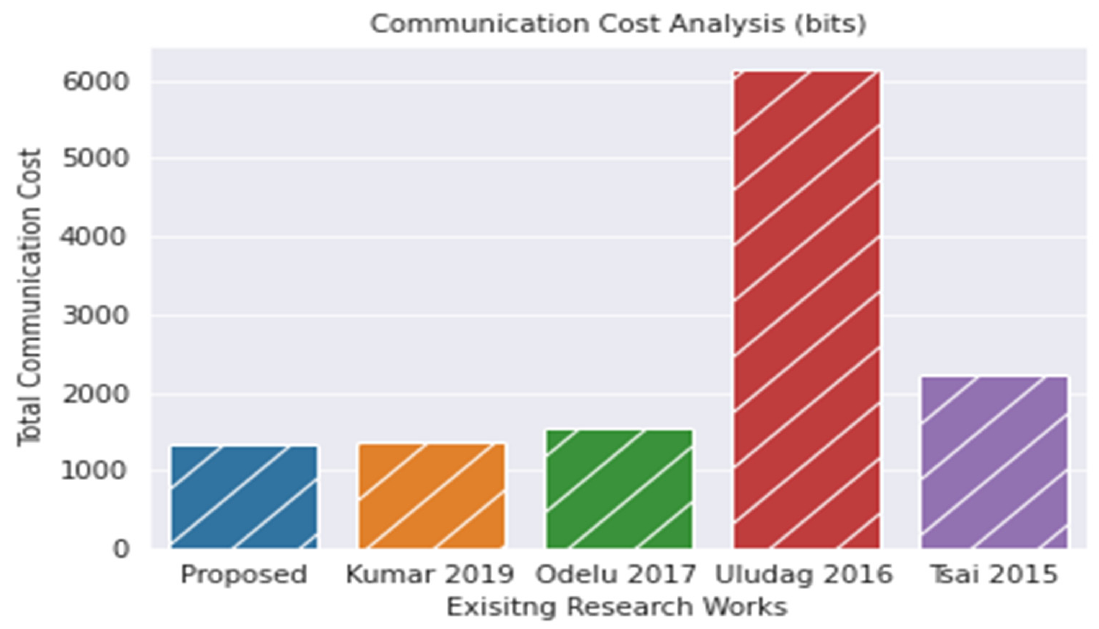
Figure 8. Comparative performance analysis between proposed and existing works in terms of communication cost analysis [8,9,12,13].